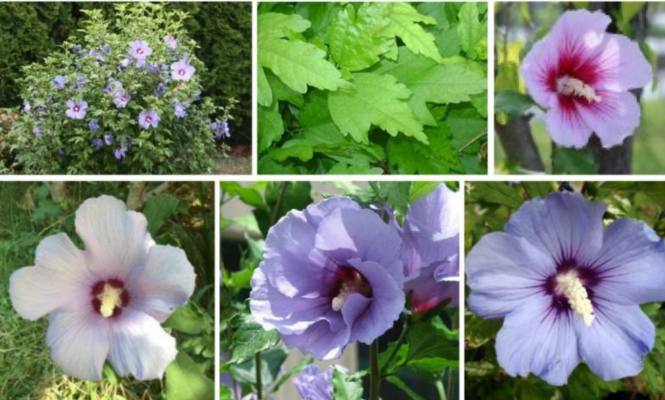
Figure 3. ( Top ) Leaves and flowers of Hibiscus syriacus ; ( Bottom ) three light purple/purplish